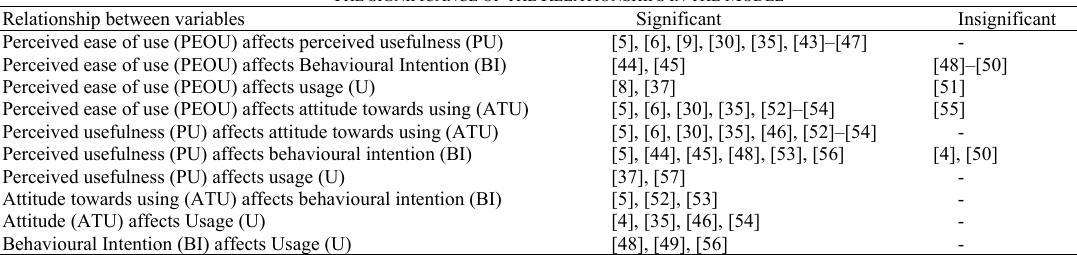
TABLE 2 T HE SIGNIFICANCE OF THE R ELATIONSHIPS IN THE M